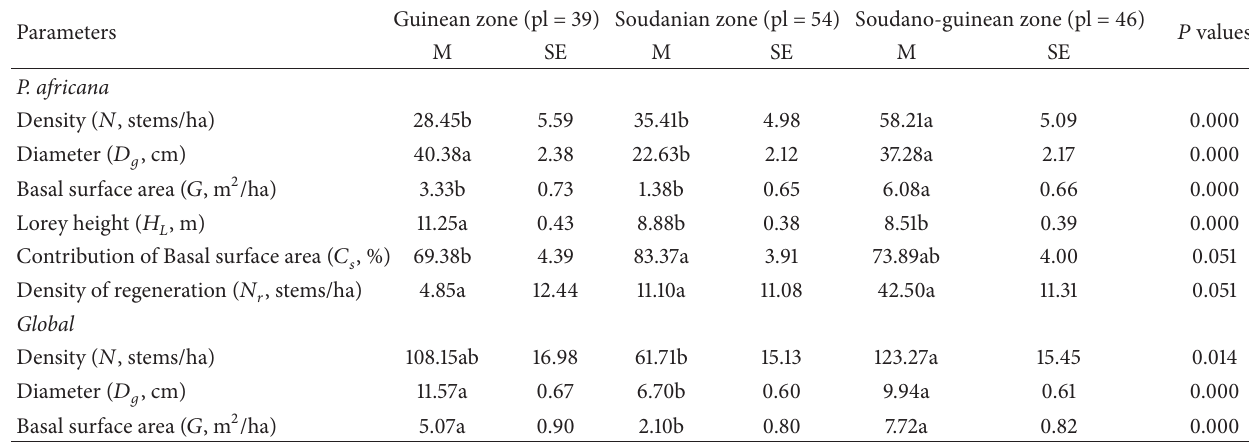
Table 5: Dendrometric characterization of P. africana according to climate